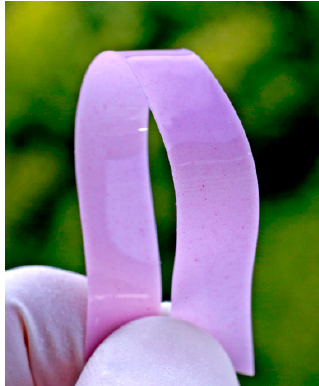
Figure 2. Ribbon of an ultrahigh-molecular-weight polyethylene (UHMWPE)–[Fe(NH 2 trz) 3 ](2ns) 2 blend comprising 33.3% m / m [Fe(NH 2 trz) 3 ](2ns) 2 prepared by gel-processing with stearic acid as solvent (formulation of 10% m / m UHMWPE in 90% m / m stearic acid), after extraction of stearic acid in diethyl ether. The width of the ribbon amounts to ~10 mm (sample is undrawn).